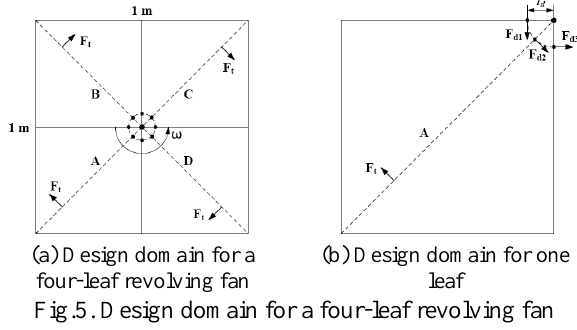
Fig.5. Design domain for a four-leaf revolving fan